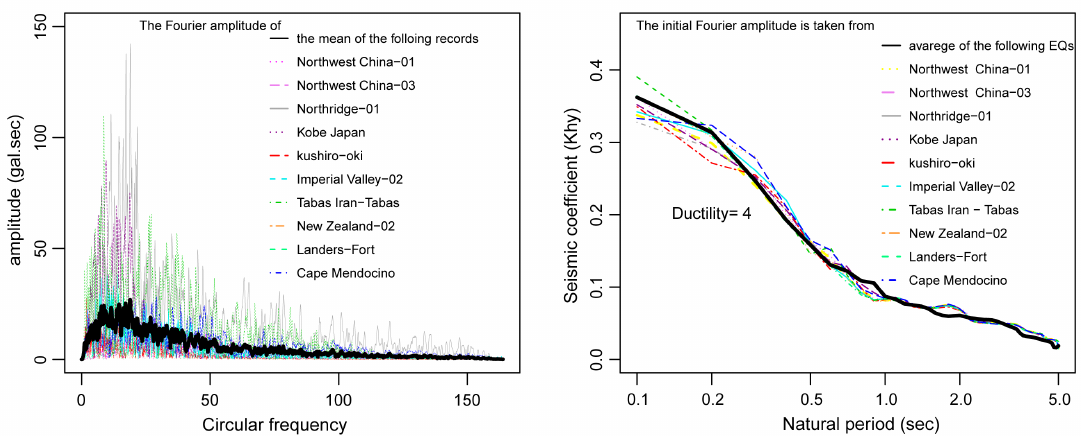
Figure 9. ( a ) Fourier amplitude of ten different observed ground motions and their mean and ( b ) YSC demand spectra obtained by simulated ground motions according to individual Fourier amplitude and their mean.